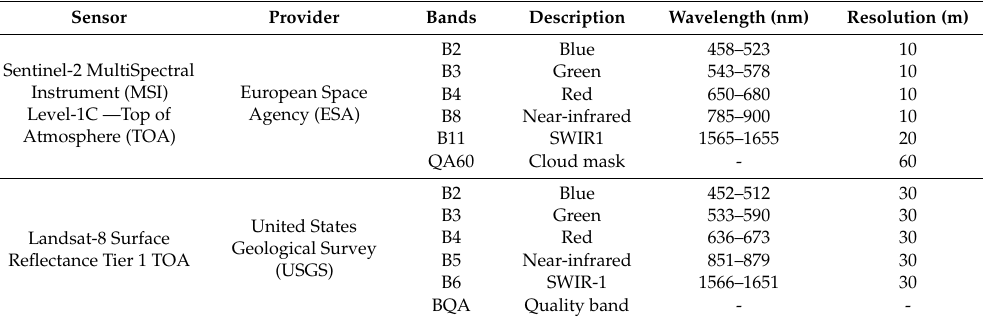
Table 1. Characteristic of the Sentinel-2 and Landsat-8 remote sensing data used in the study.